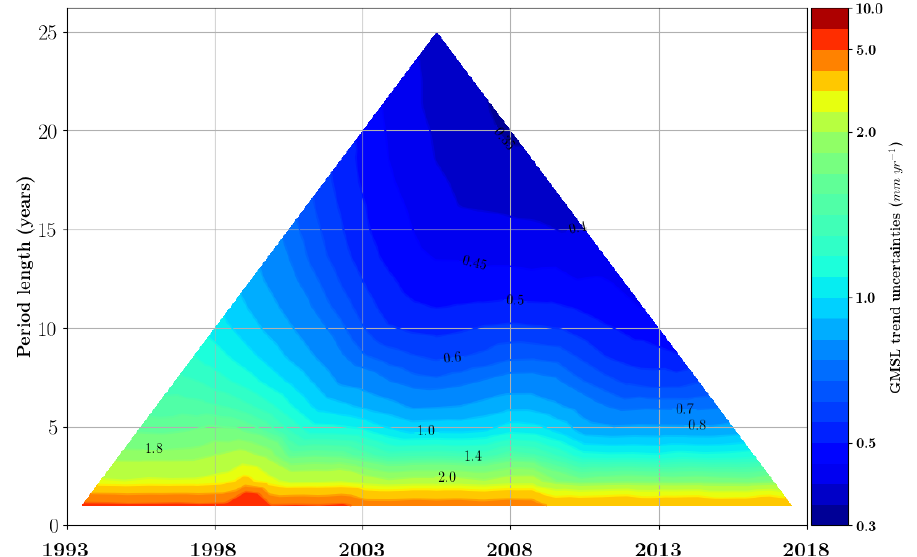
Figure 5. GMSL trend uncertainties (mmyr − 1 ) estimated for all altimeter periods within the 25-year period (January 1993 to Decem- ber 2017). The confidence level is 90% (1 . 65 σ ). Each colored pixel represents, respectively, the half-size of the 90% confidence range in the GMSL trend. Values are given in mmyr − 1 . The vertical axis indicates the length of the period (ranging from 1 to 25 years) considered in the computation of the trend, while the horizontal axis indicates the center date of the period (for example, 2000 for the 20-year period 1990–2009).